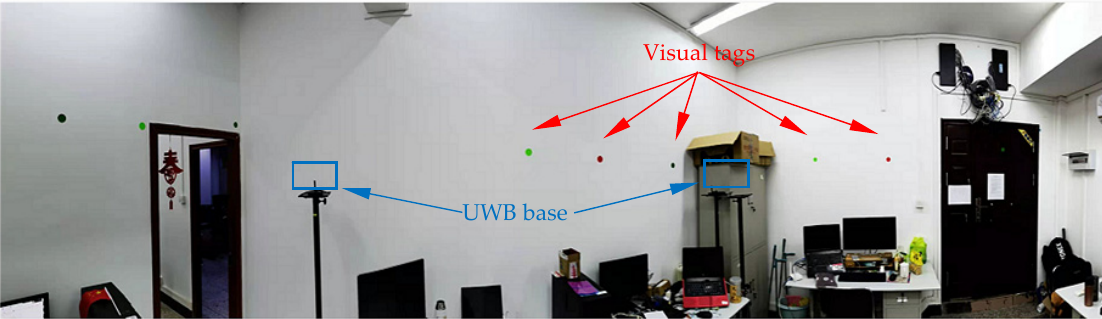
Figure 10. Indoor location scenario.